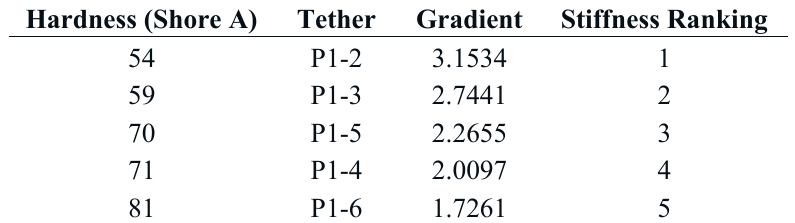
Table 5. Tabulated results of the linear regressions shown in Figure